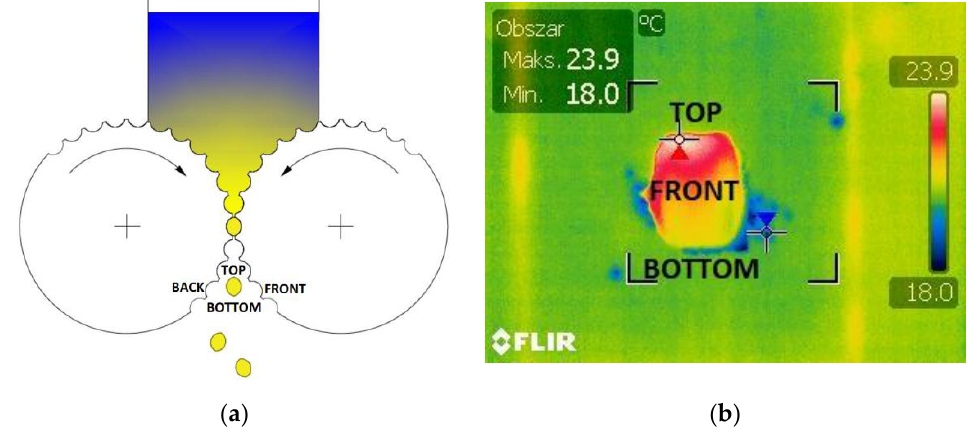
Figure 7. The briquettes arrangement: ( a ) in the compacting unit of the roller press; ( b ) on the plywood pad .